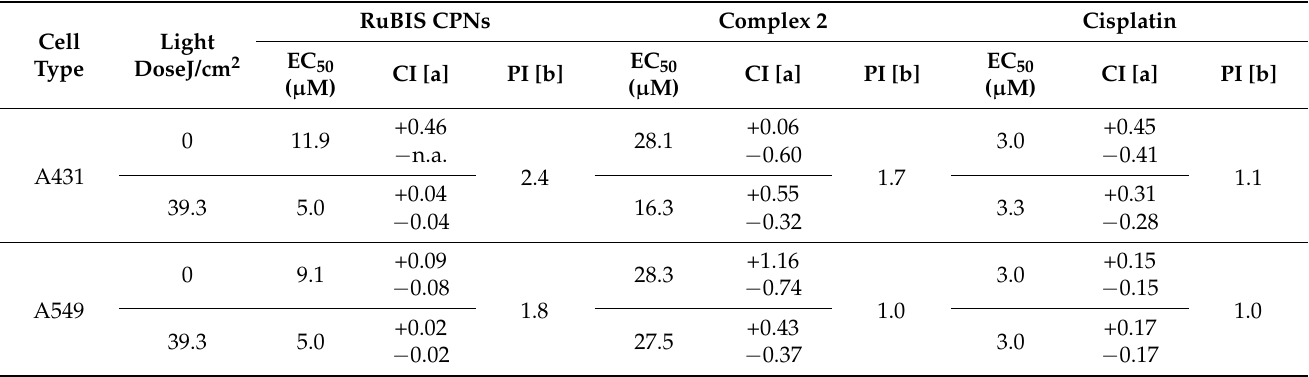
Table 1. Cytotoxicity of RuBIS CPNs and complex 2 in A431 and A549 cancer cell lines in the dark and under green light ( λ exc = 520 nm, 39.3 J/cm 2 ) irradiation. Cell Type